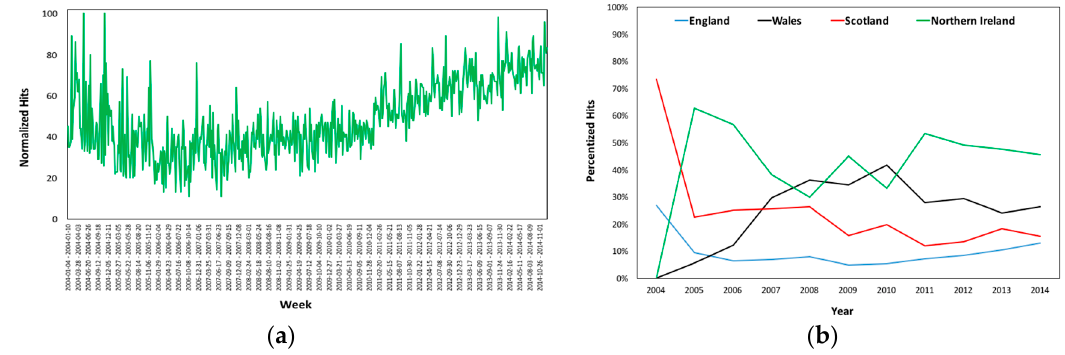
Figure 5. Azithromycin’s ( a ) Normalized Hits in the UK and ( b ) Regional Percentized Hits Averages 2004–2014.